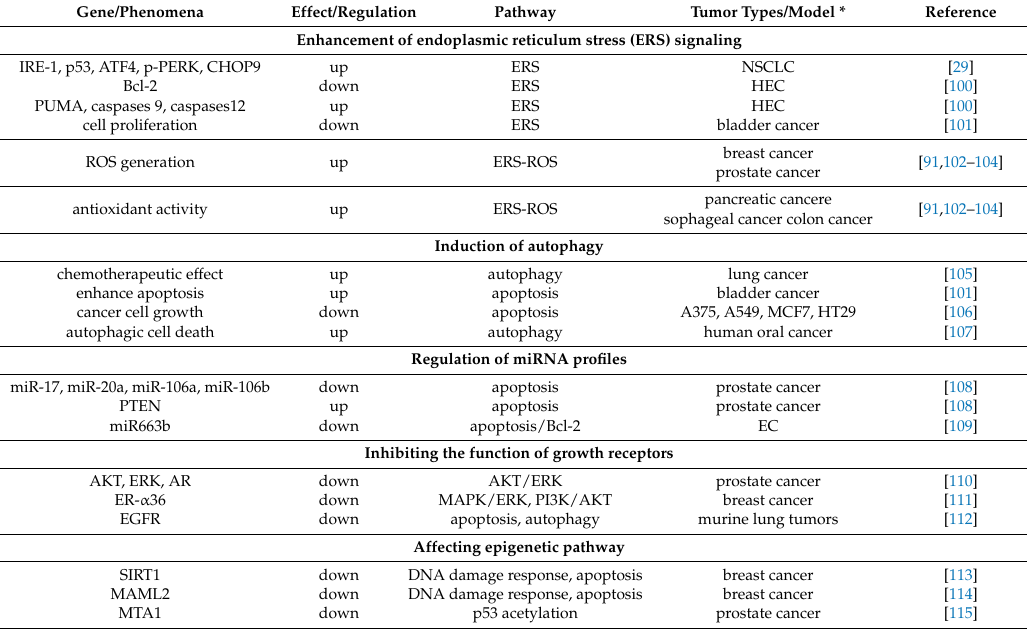
Table 1. Summary of pro-apoptotic effects of PS against